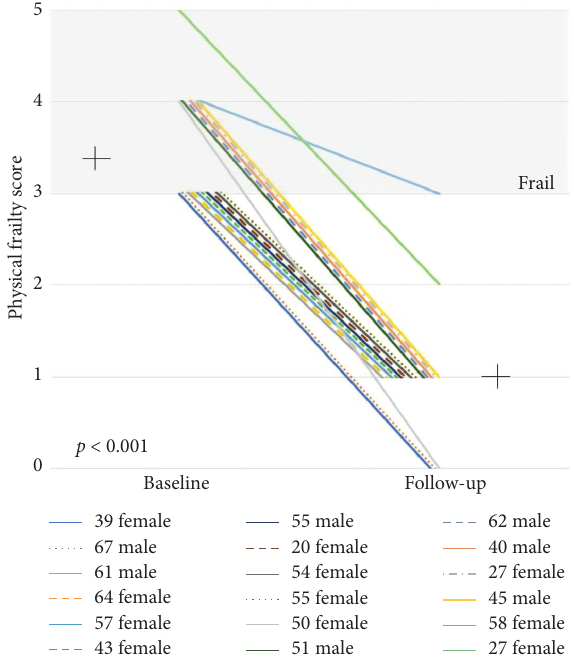
Figure 3: Changes to physical frailty score pre-LTX vs. post-LTX.